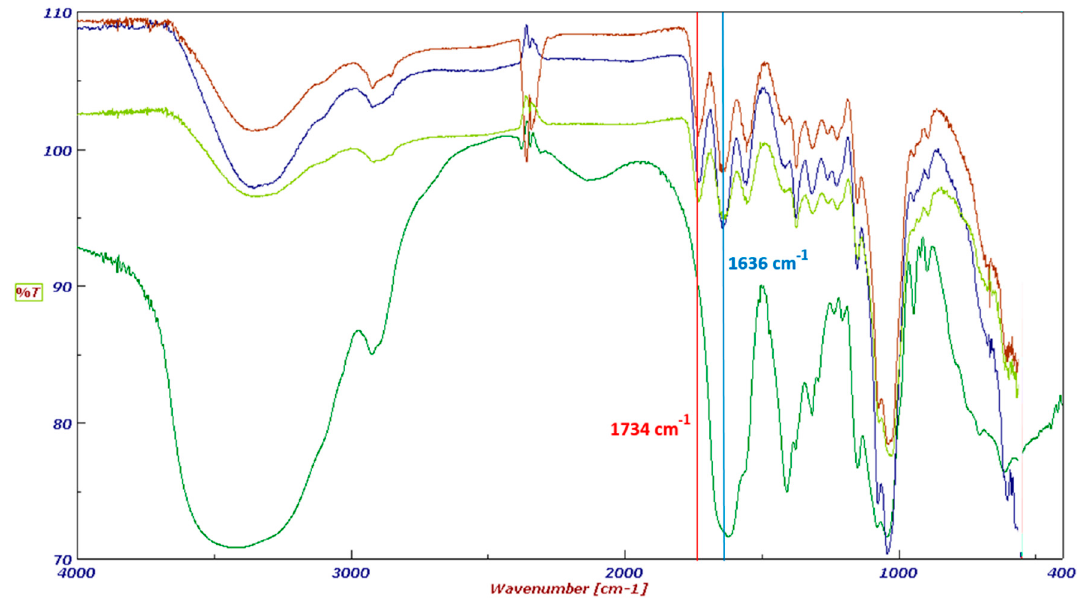
Figure 1. FT-IR spectra of HA (dark green), HA-palmitate (blue), HA-oleate (brown), and HA-linoleate (light green).